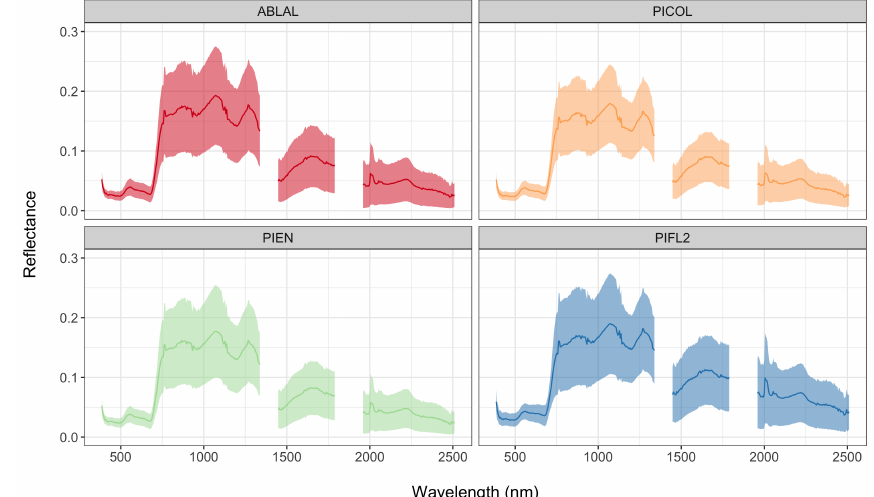
Figure 6. Mean hyperspectral reflectance per species from 380 to 2510 nm, extracted from all polygons with half the max crown diameter at the NEON NIWO site for each of the dominant tree species: ABLAL (Subalpine fir), PICOL (Lodgepole pine), PIEN (Engelmann spruce), and PIFL2 (Limber pine). Shading illustrates +/– one standard deviation in reflectance per wavelength. Gaps in the spectra at approximately 1350 nm and 1800 nm are where “bad bands” were removed where there is high atmospheric